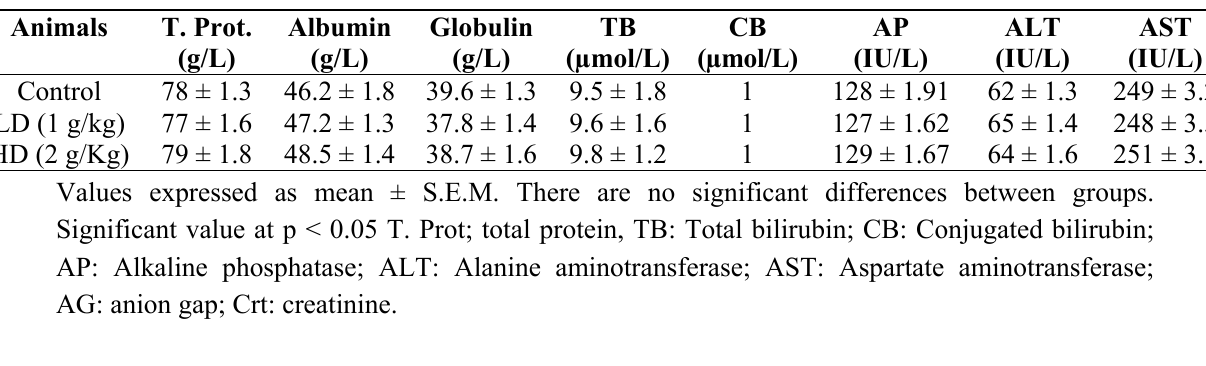
Table 3. Liver function test of rats in acute toxicity study of CuLBS compound.